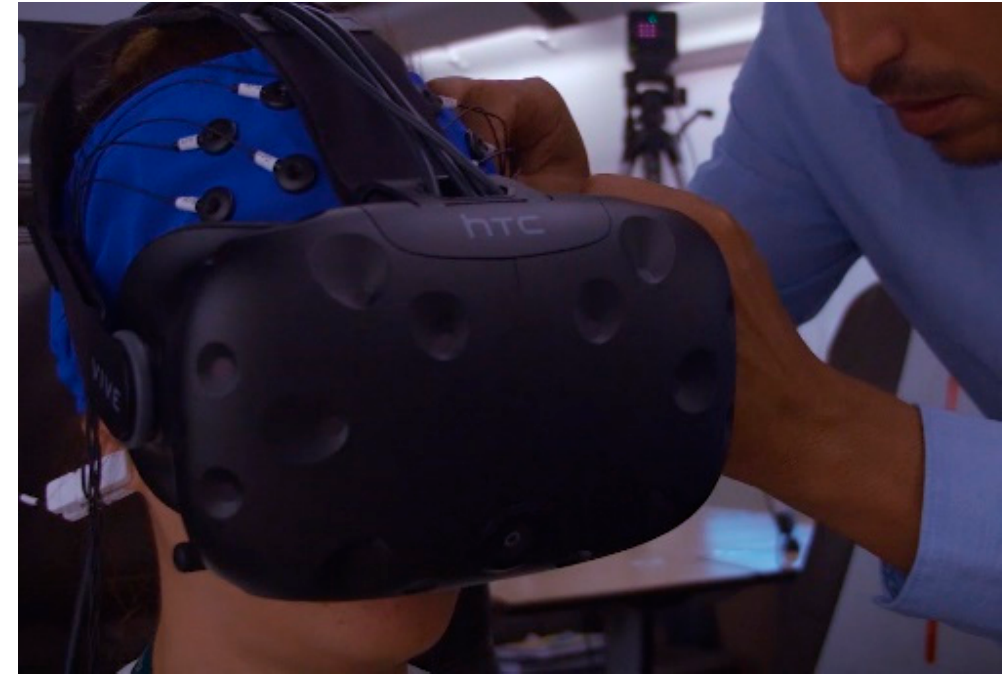
Figure 2. Electroencephalography (EEG) and Virtual Reality (VR) equipment setup.